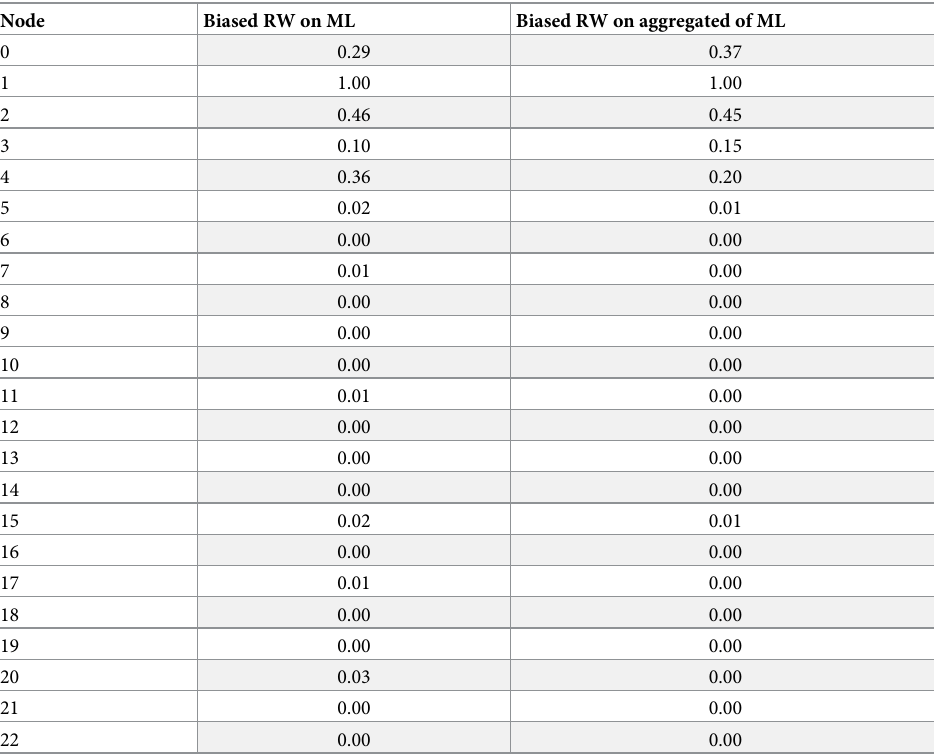
Table 6. Biased random walk on a typical multilayer network versus its aggregated network. Node Biased RW on ML Biased RW on aggregated of